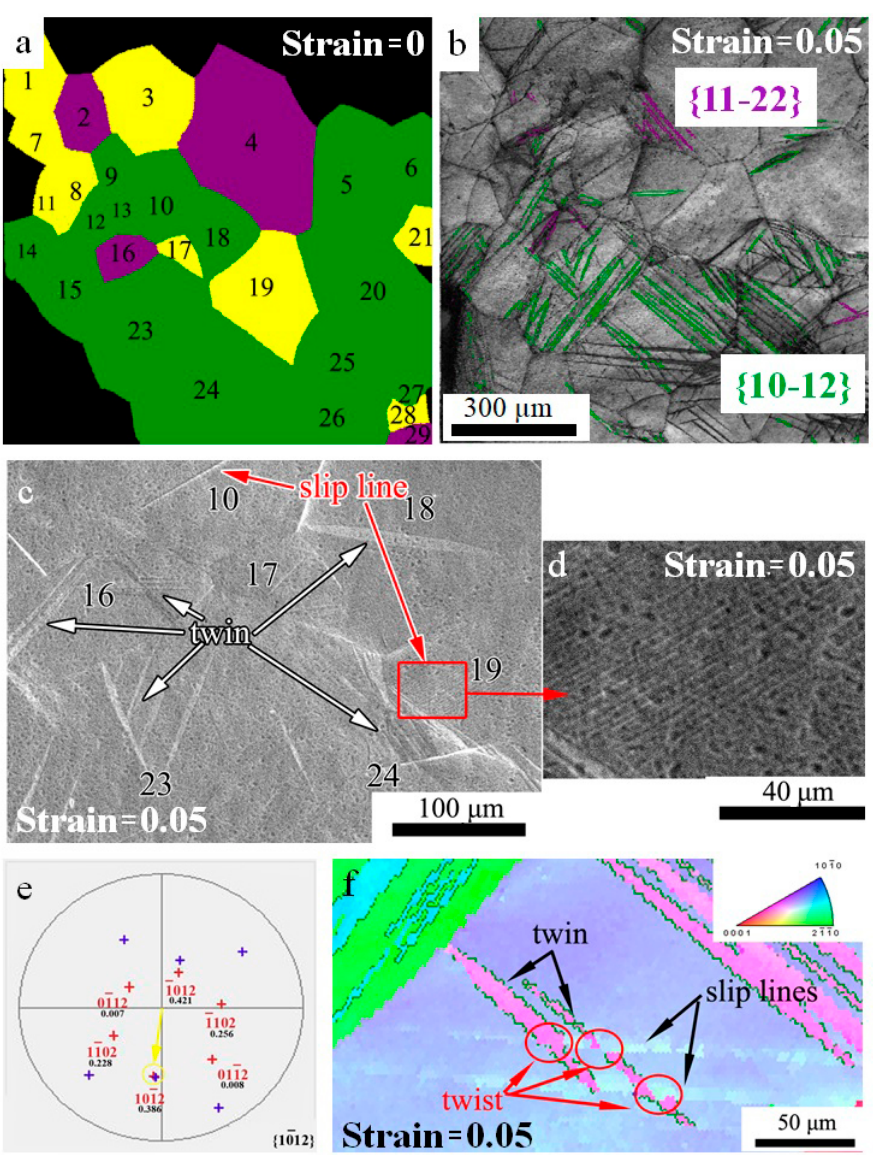
Figure 4. ( a ): The undeformed grains where twinning is going to happen. The grains painted green, purple, and yellow indicate {1012} twins, {1122} twins, and no twins, respectively. ( b ): Microstructure with the boundaries of {1012} twins in green and {1122} twins in purple; ( c , d ): SEM morphology with twins and slip lines; ( e ) pole figure and ( f ) IPF map of Grain No. 24 at the 0.05 strain level.